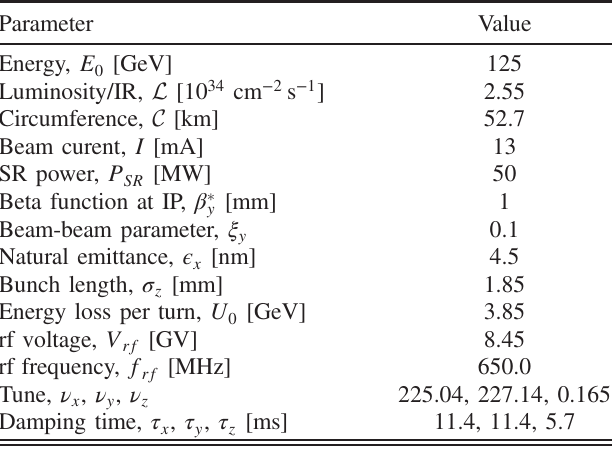
TABLE III. Main parameters of a circular Higgs factory.